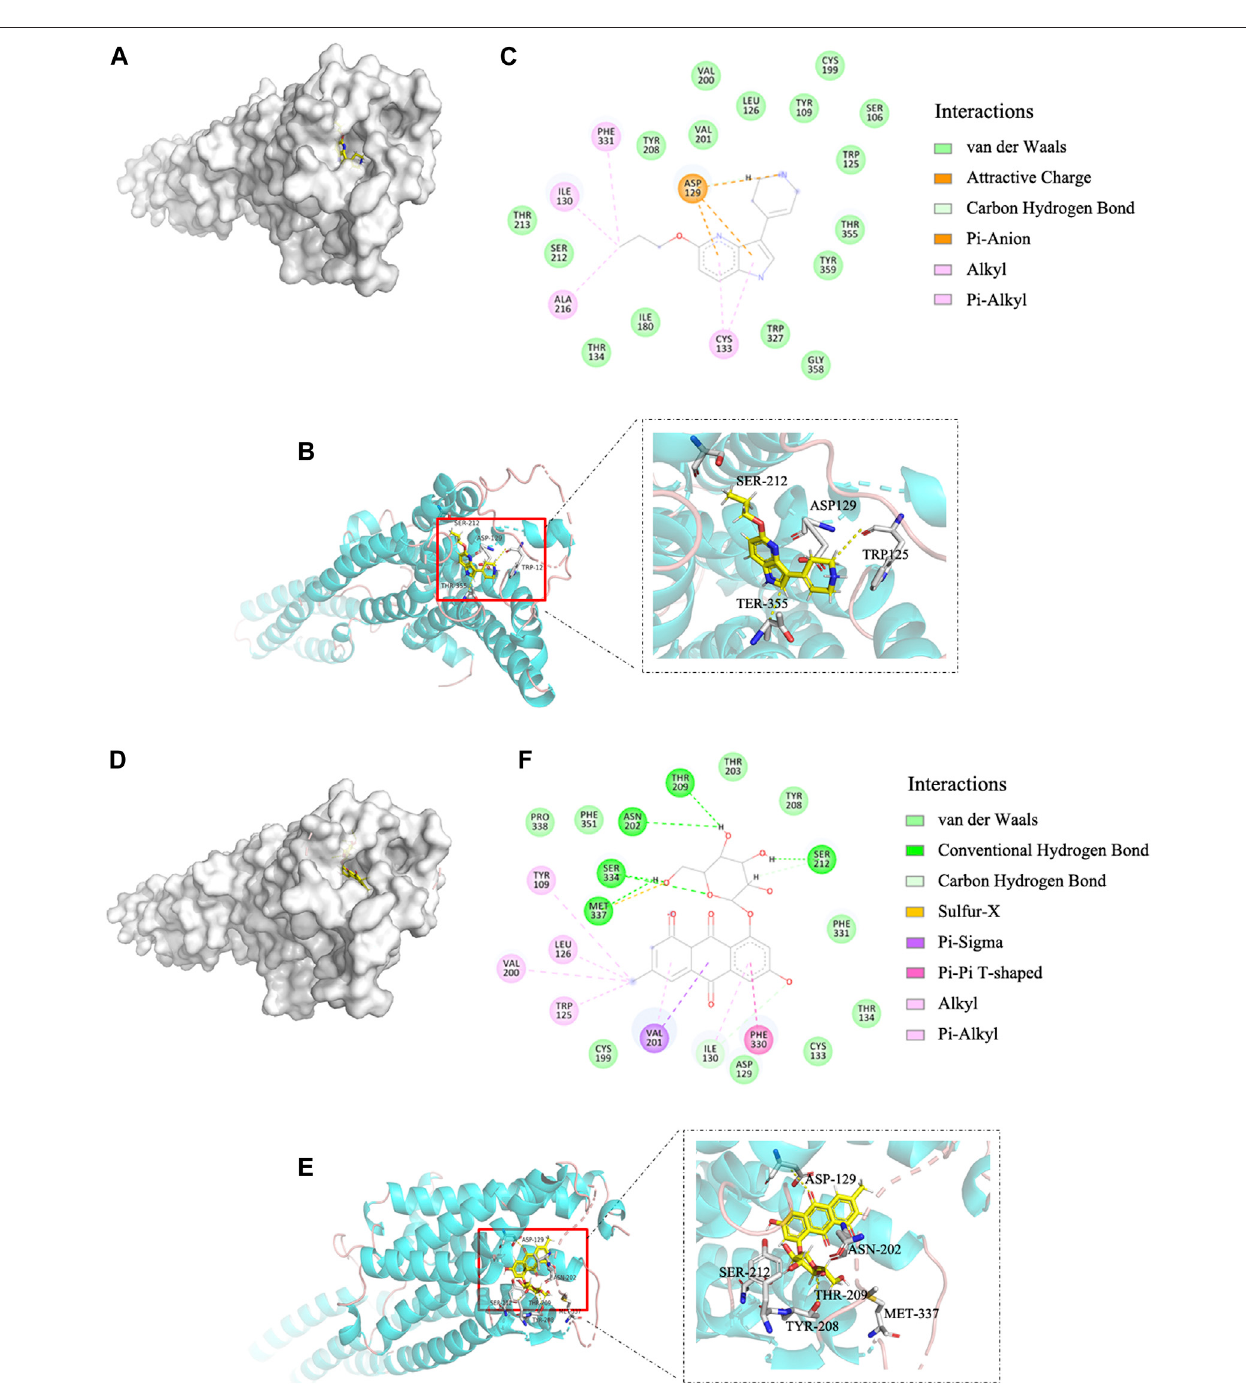
FIGURE1| EGisa5-HT 1B ligandinmoleculardockingcompared withagonist CP-94253. (A) Electrostaticsurfacemodel. (B) Schematicrepresentation ofcrystal structure. (C) Magni fi ed 2D-view of protein-ligand CP-94253 docking into its 5-HT 1B interacting pocket. (D − F) Corresponding representations of EG docking into the same 5-HT 1B interacting pocket as CP-94253. EG: emodin-8-O- β - D -glucopyranoside; 5-HT 1B : serotonin receptor 1B; CP-94253: 4-{5-propoxypyrrolo [3,2-b]pyridin- 3-yl}-1,2,3,6-tetrahydropyridine.